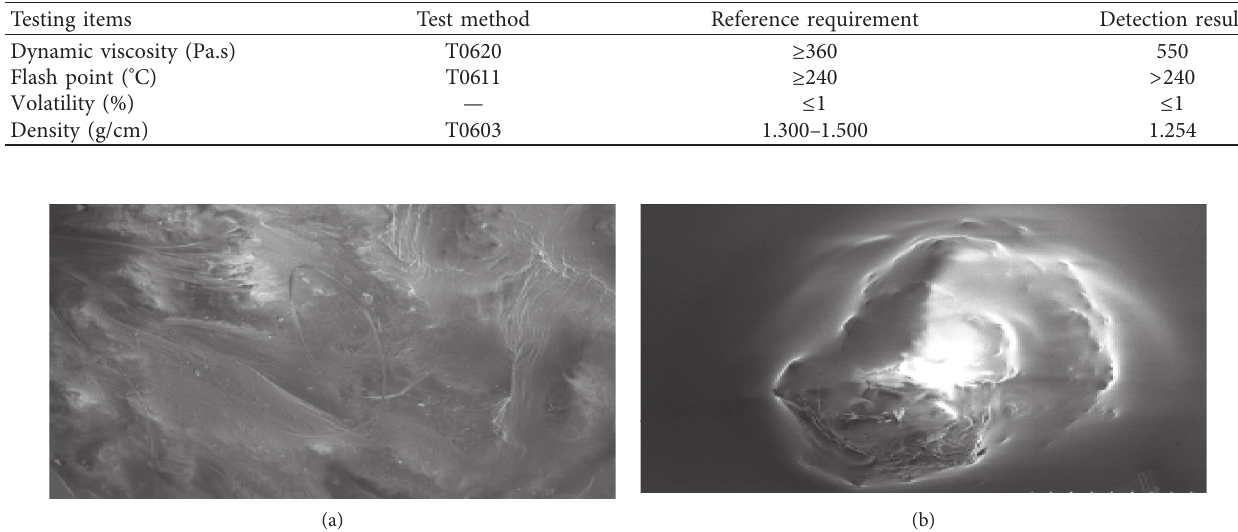
Figure 2: Electron micrograph of plant asphalt. (a) Low power microscopic results. (b) High power microscopic results.